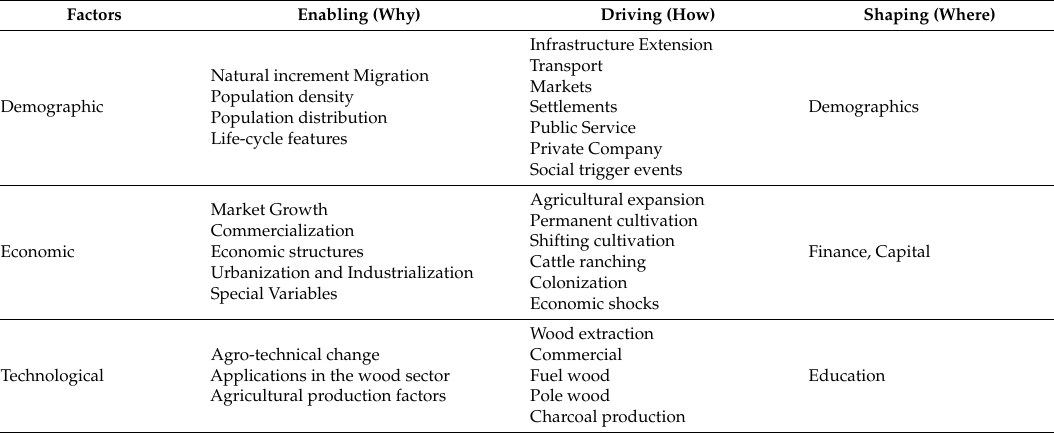
Table 1. Driving Factors for land system dynamics and land change (based on